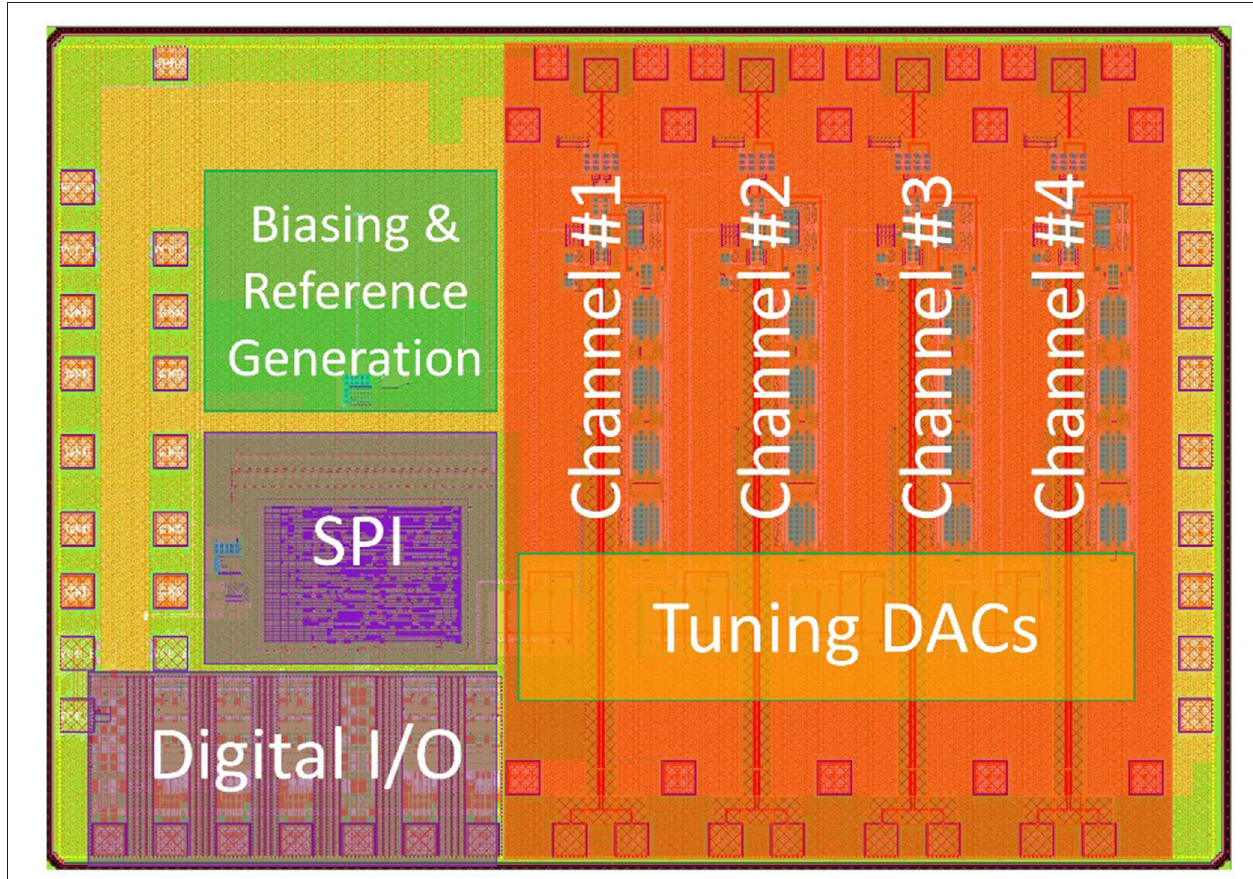
FIGURE 10 | VCSEL driver top layout with block functions